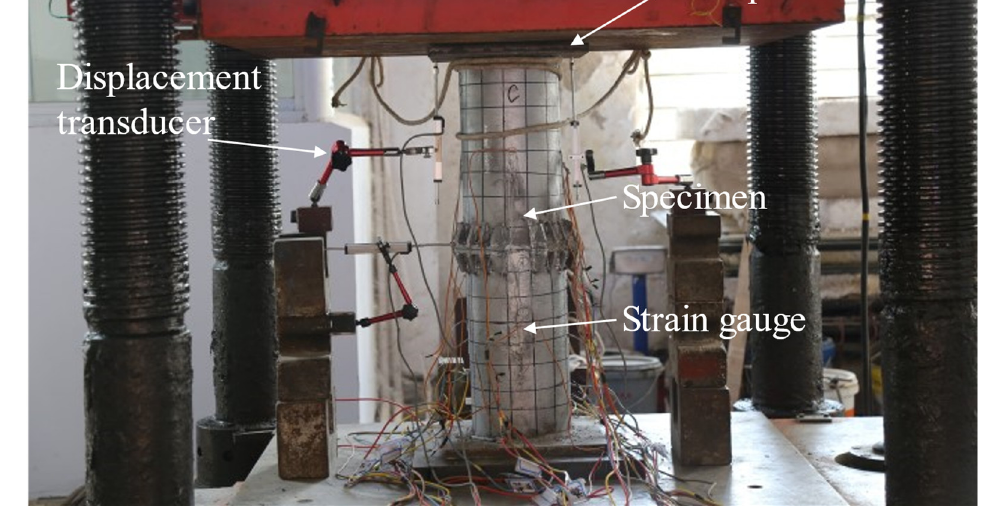
Figure 3. Test set-up. Displacement transducers were set up at the top cover plate of the specimen to meas- ure the axial deformation of the BWCFST short column specimen, as shown in Figure 4. Strain gauges were placed on the outer surface of the steel tube at the height of 1/4, 1/2 and 3/4 of column to measure the transverse and longitudinal strains of the specimen. The strain gauge layout scheme is shown in Figure 4. The 1 and 1′ (and the other serial num- bers) represent the transverse strain gauge and the longitudinal strain gauge, respectively.